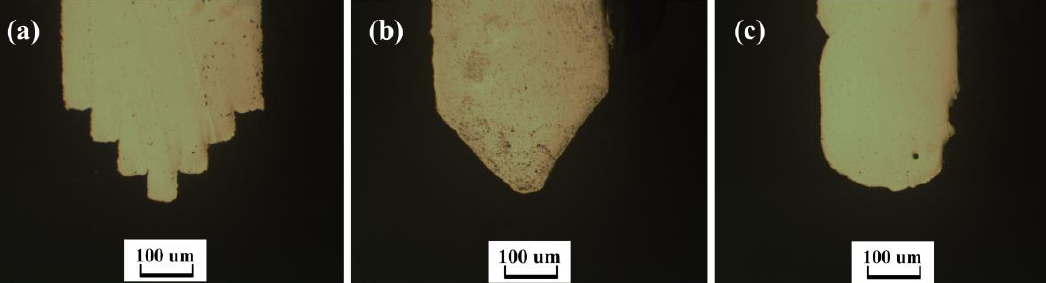
Figure 4. Sectional views of microelectrodes fabricated with different bonding temperatures: ( a ) 900 °C; ( b ) 950 °C; ( c ) 1000 °C.